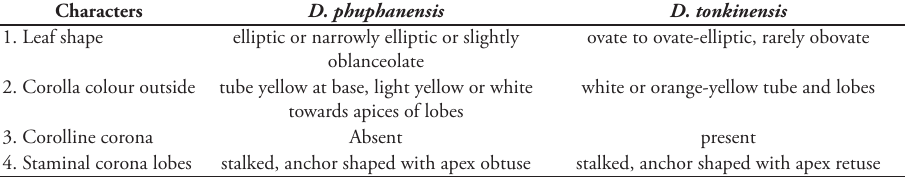
Table 1. Distinguishing features between Dischidia phuphanensis and D. tonkinensis